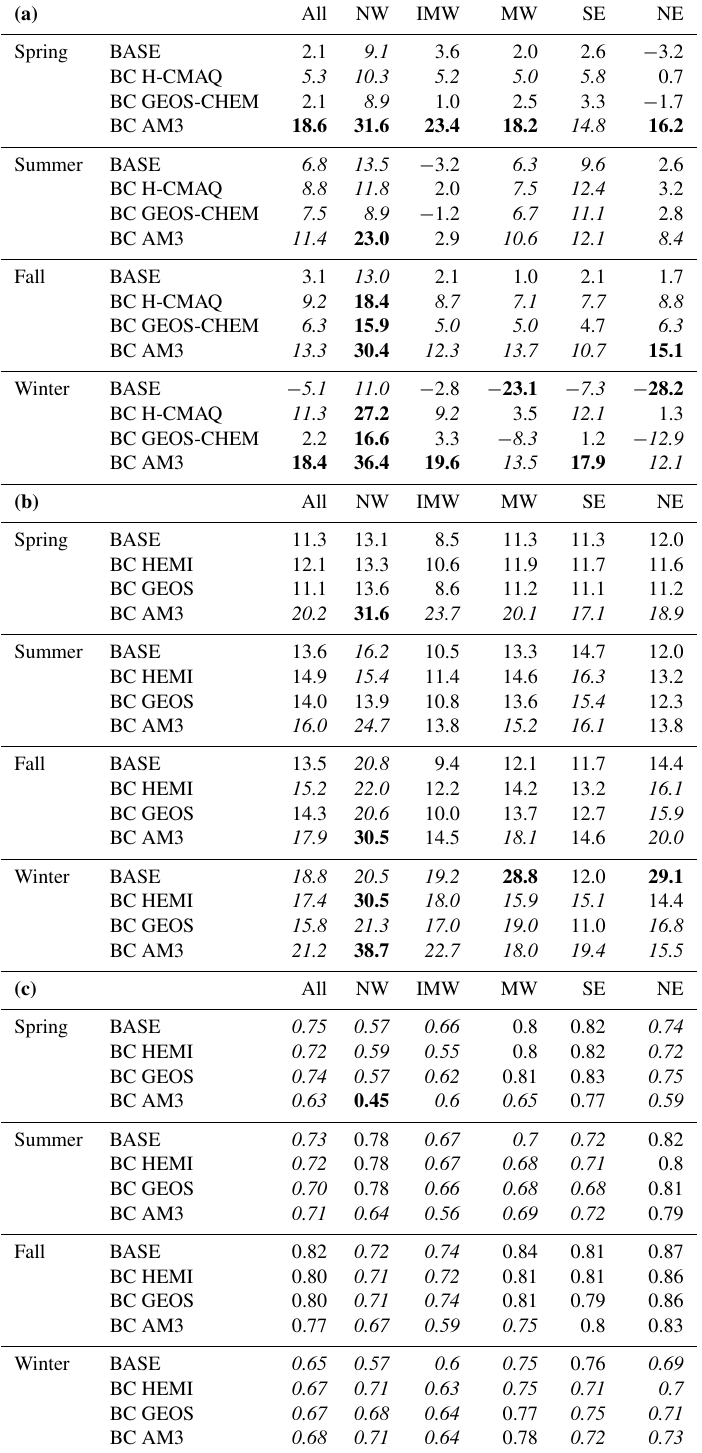
Table 4. (a) NMB for MDA8 ozone at AQS sites for BASE, BC H-CMAQ, BC GEOS-Chem, and BC AM3. See the legend for Table 3 for a description on how the metrics were computed and for a definition of how different fonts are used in this table. (b) NME for MDA8 ozone at AQS sites for BASE, BC H-CMAQ, BC GEOS-Chem, and BC AM3. See the legend for Table 3 for a description on how the metrics were computed and for a definition of how different fonts are used in this table. (c) R for MDA8 ozone at AQS sites for BASE, BC H-CMAQ, BC GEOS-Chem, and BC AM3. See the legend for Table 3 for a description on how the metrics were computed and for a definition of how different fonts are used in this